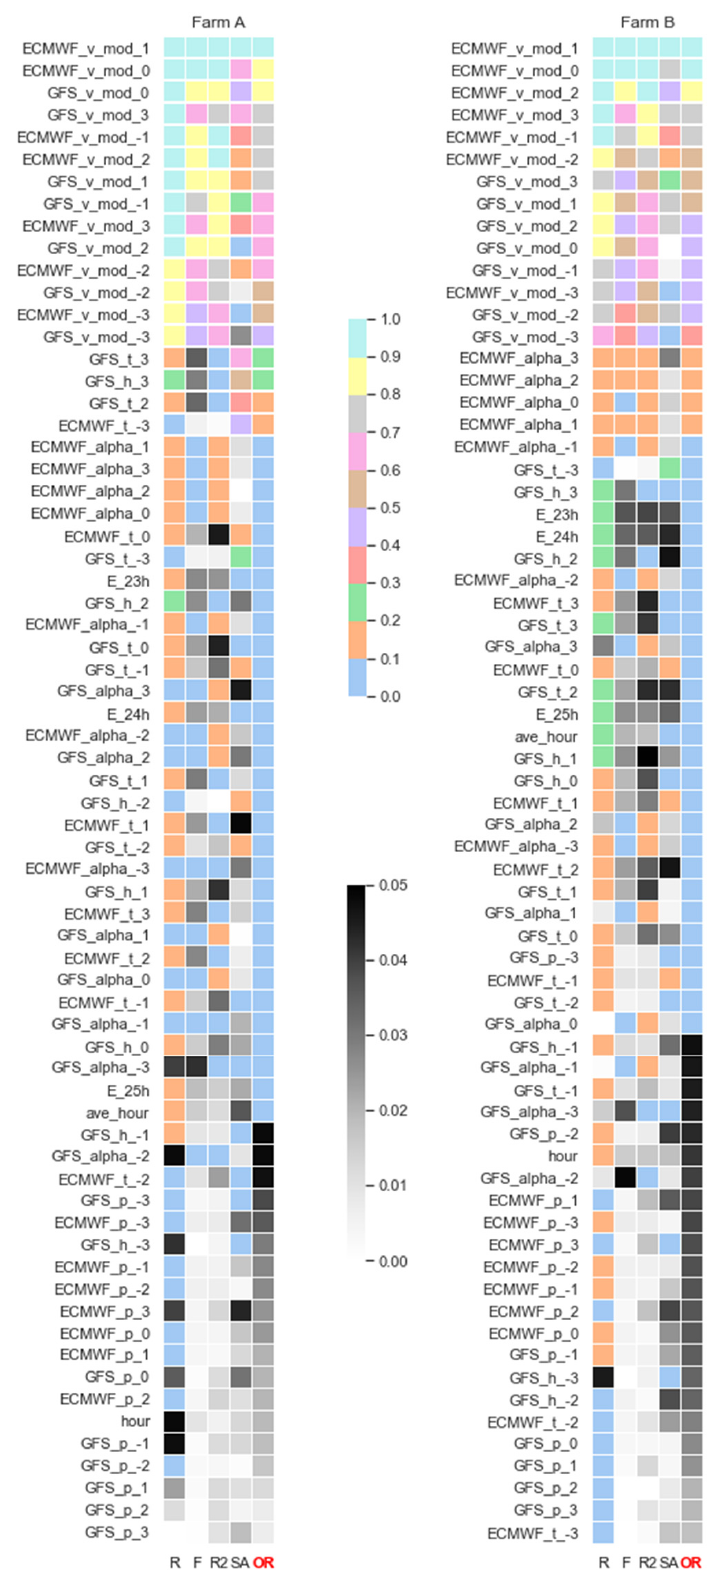
Figure 10. Results of sensitivity analysis of potential input variables for prediction models for Wind Farm A and Wind Farm B: 4 analysis methods and final Overall Rating (OR).